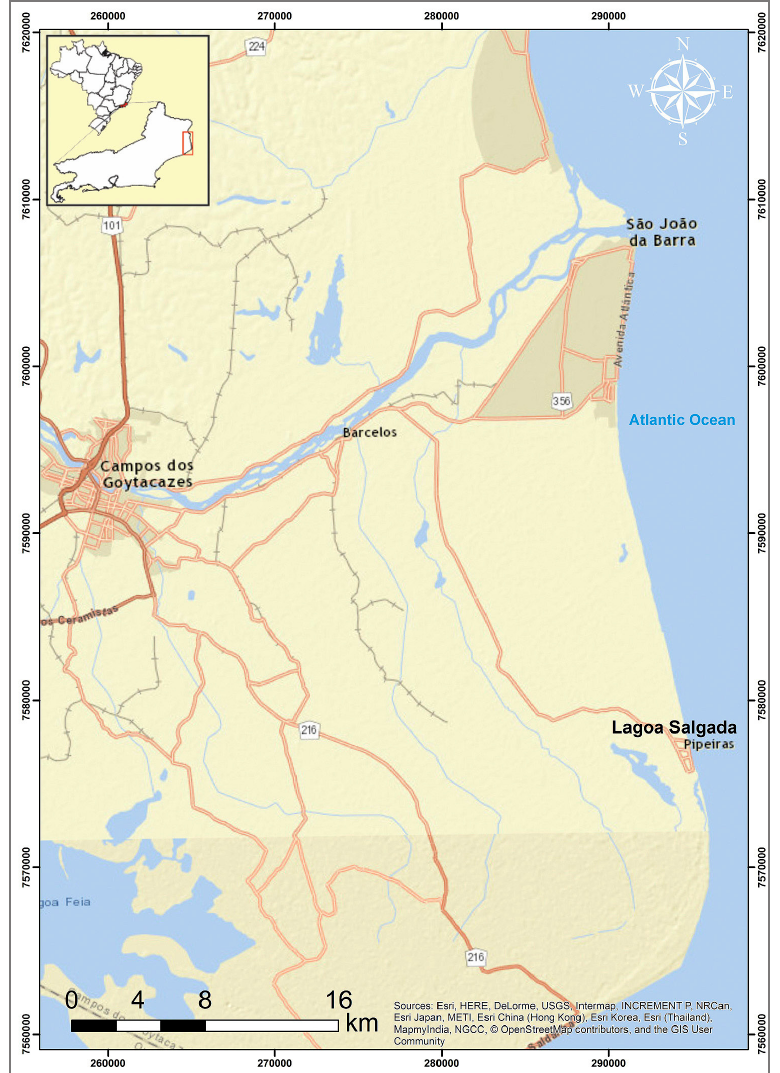
Figure 1 - Map with of the location of Lagoa